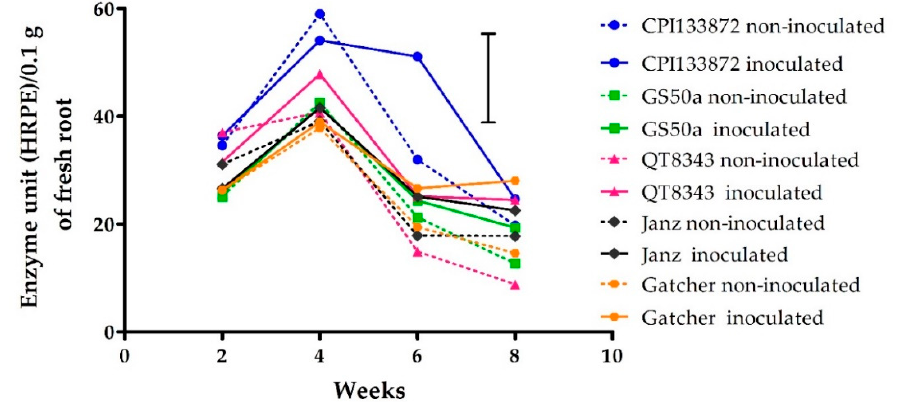
Figure 5. Peroxidase activity (horse radish peroxidase equivalent (HRPE) / 0.1 g fresh root) from 2–8 weeks in the roots Pratylenchus thornei of inoculated (solid line) and non-inoculated (dotted line) resistant wheat genotypes—CPI133872 (blue), GS50a (green), and QT8343 (red)—and susceptible wheat genotypes—Janz (black) and Gatcher (orange). The values are the mean of three replicates. The bar marker is LSD = 17 ( p = 0.05) for the interaction genotype* P. thornei * time.